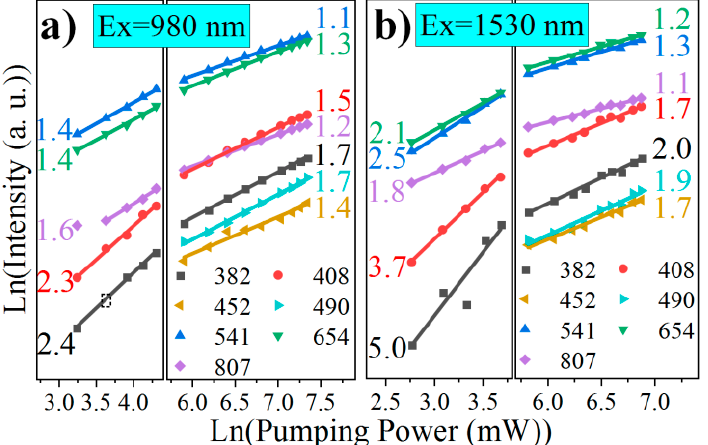
Figure 5. Measured emission intensities from Er 3+ 4 G 11/2 , 2 H 9/2 , 4 F 5/2 , 4 F 7/2 , 4 S 3/2 , 4 F 9/2 , and 4 I 9/2 levels at 382, 408, 452, 490, 541, 654, and 807 nm, respectively, in the 10Er sample versus the pumping powers of ( a ) 980 and ( b ) 1530 nm excitation. The numbers denote the slopes of the power dependencies.